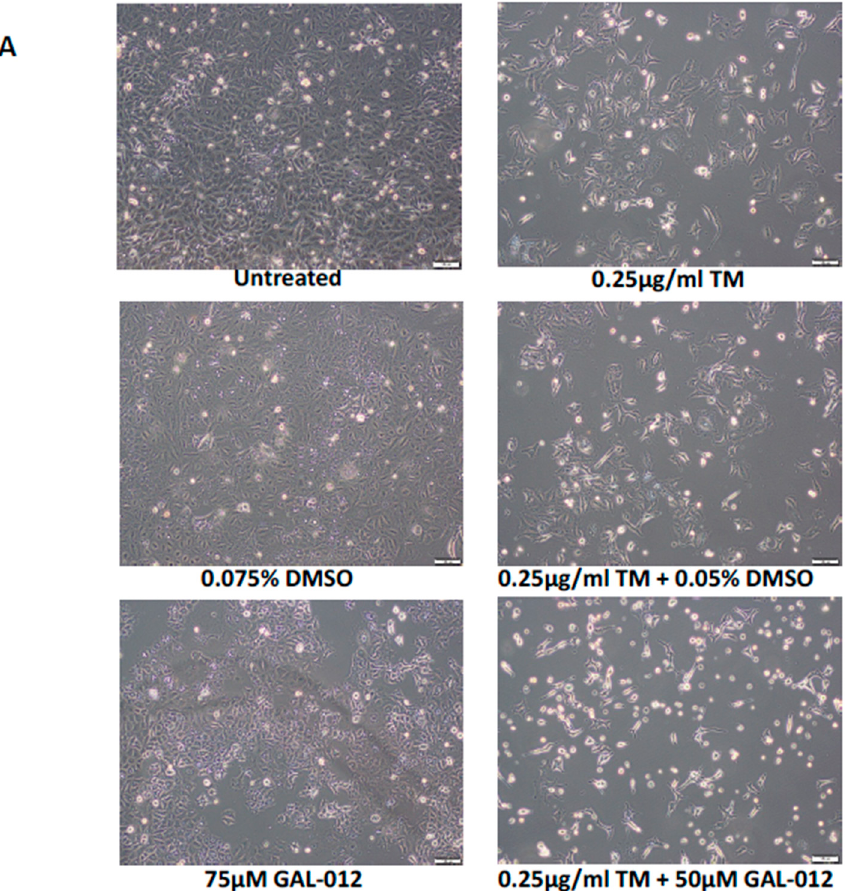
Figure 6. Cont Figure 6. Cont.